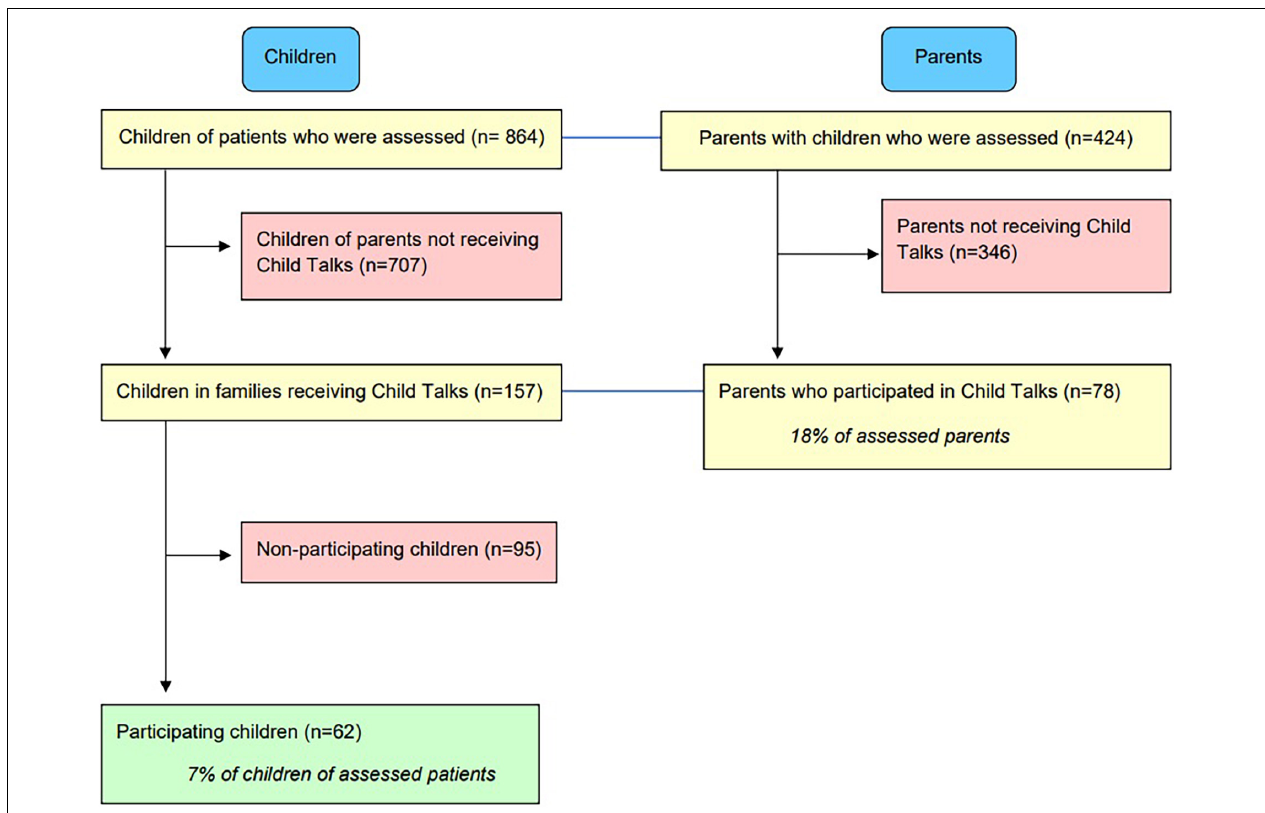
FIGURE 1 | Childrens’ participation in Child